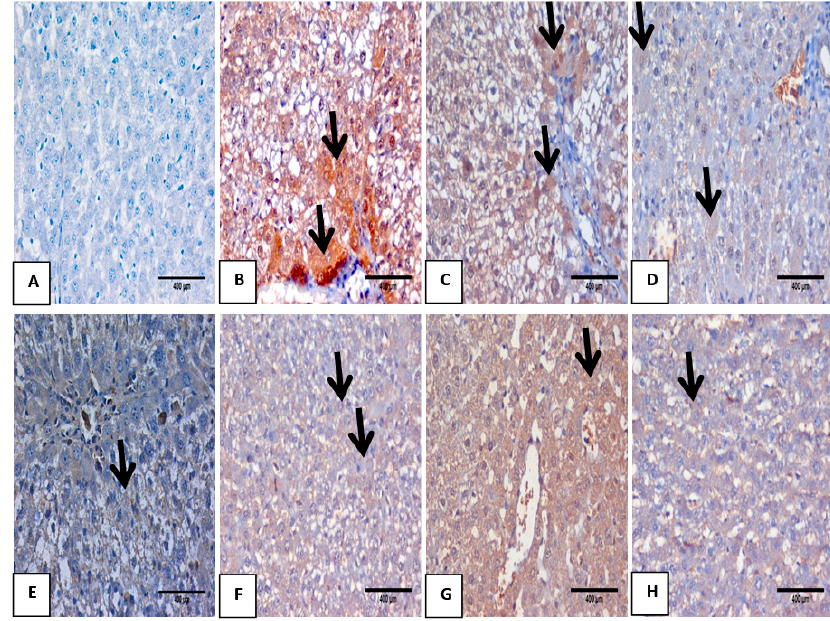
Figure 7. Liver section stained with immunohistochemistry for TNF- α .from( A ) normal control group showed negative expression of TNF- α ; ( B ) TAA intoxicated liver (positive control) showed marked expression of TNF- α as a brownish cytoplasmic stain of hepatocytes in about ± 70% (black arrow); ( C , D ) oral treatment with Ms and NM. As +ve control for mustard showed very mild expression of TNF- α as a brownish cytoplasmic stain of hepatocytes in about 10–20% (black arrow); ( E , F ) liver section from pretreated groups of Ms and NMs demonstrated moderate expression of TNF- α as a brownish cytoplasmic stain of hepatocytes in about ± 20–30% (black arrow); ( G , H ) liver sections treated with Ms and NMs showed marked improvement of TNF- α expression as a brownish stain of hepatocytes in about 25–50% (black arrow) (DAB, IHC, x400).